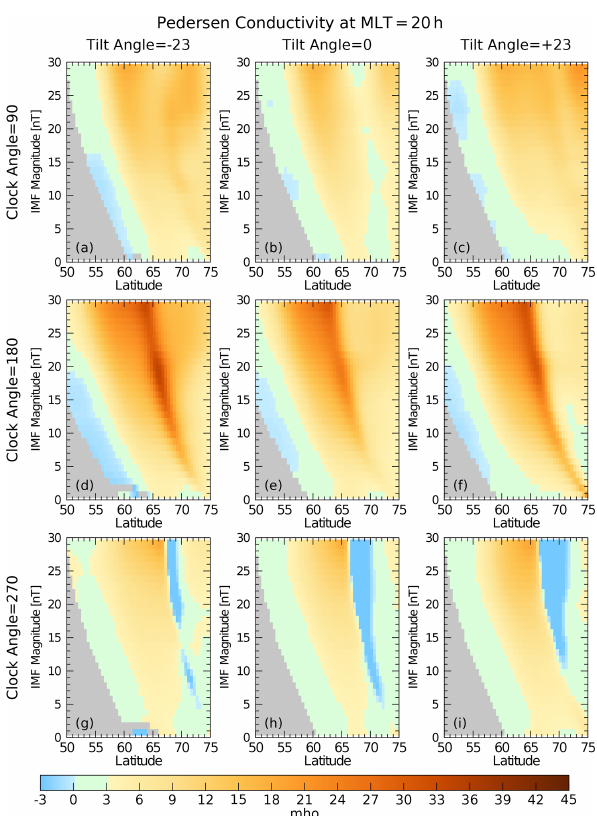
Figure 9. Hall conductivity as a function of latitude from 50 to 75 ◦ at 20:00MLT. The format of the graph is the same as in Figs. 6 to